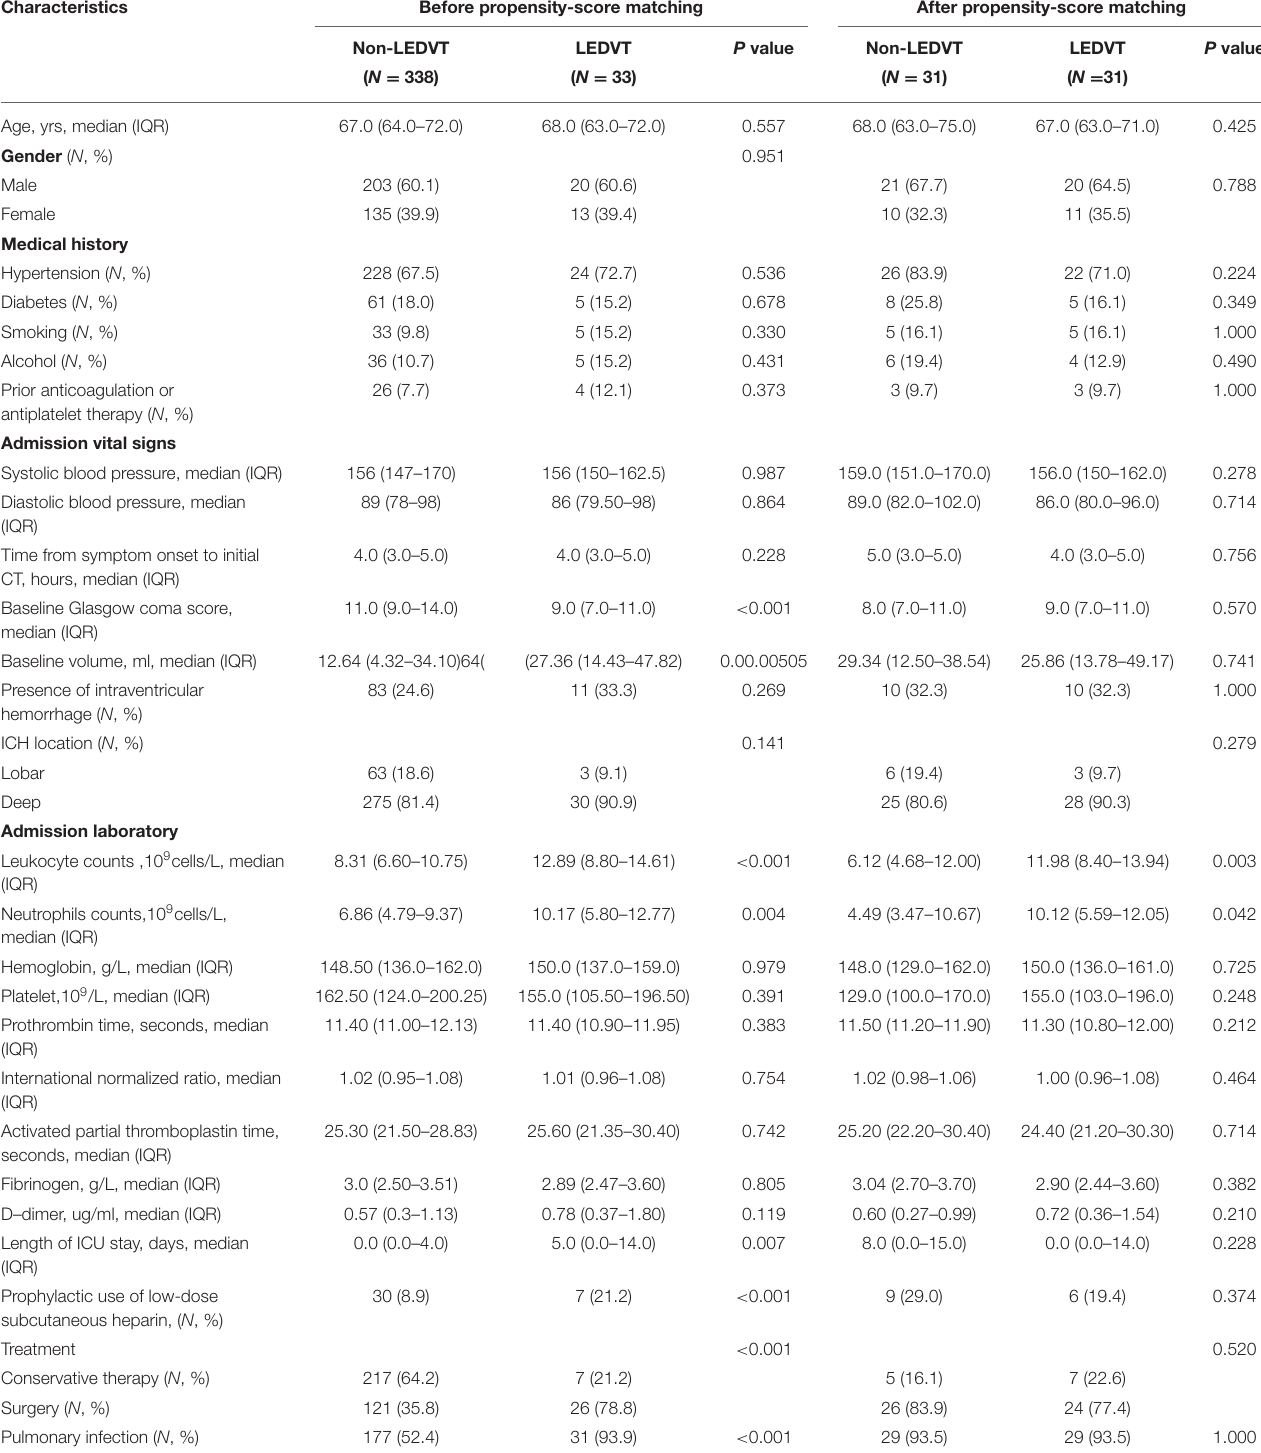
TABLE 1 | Univariate analysis of association with LEDVT before and after propensity-score matching in spontaneous intracerebral hemorrhage patients.